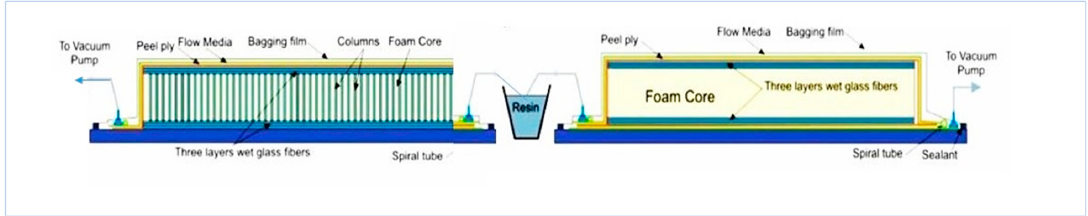
Figure 18. The schematic of the fabrication process of FCS and PRFCS composite panels. Adapted from [61] .